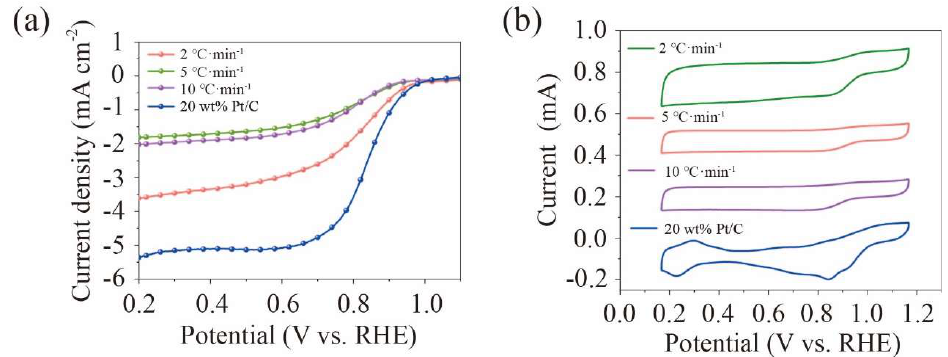
Figure 4. ( a ) RDE LSVs and ( b ) CVs of 20 wt.% Pt/C and MNNC-2 with different carbonization temperatures at a heating rate of 2 °Cmin −1 measured in O 2 -saturated 0.1 M KOH and at a scan rate of 10 mV s −1 . The rotation speed for LSV test was 1600 rpm.